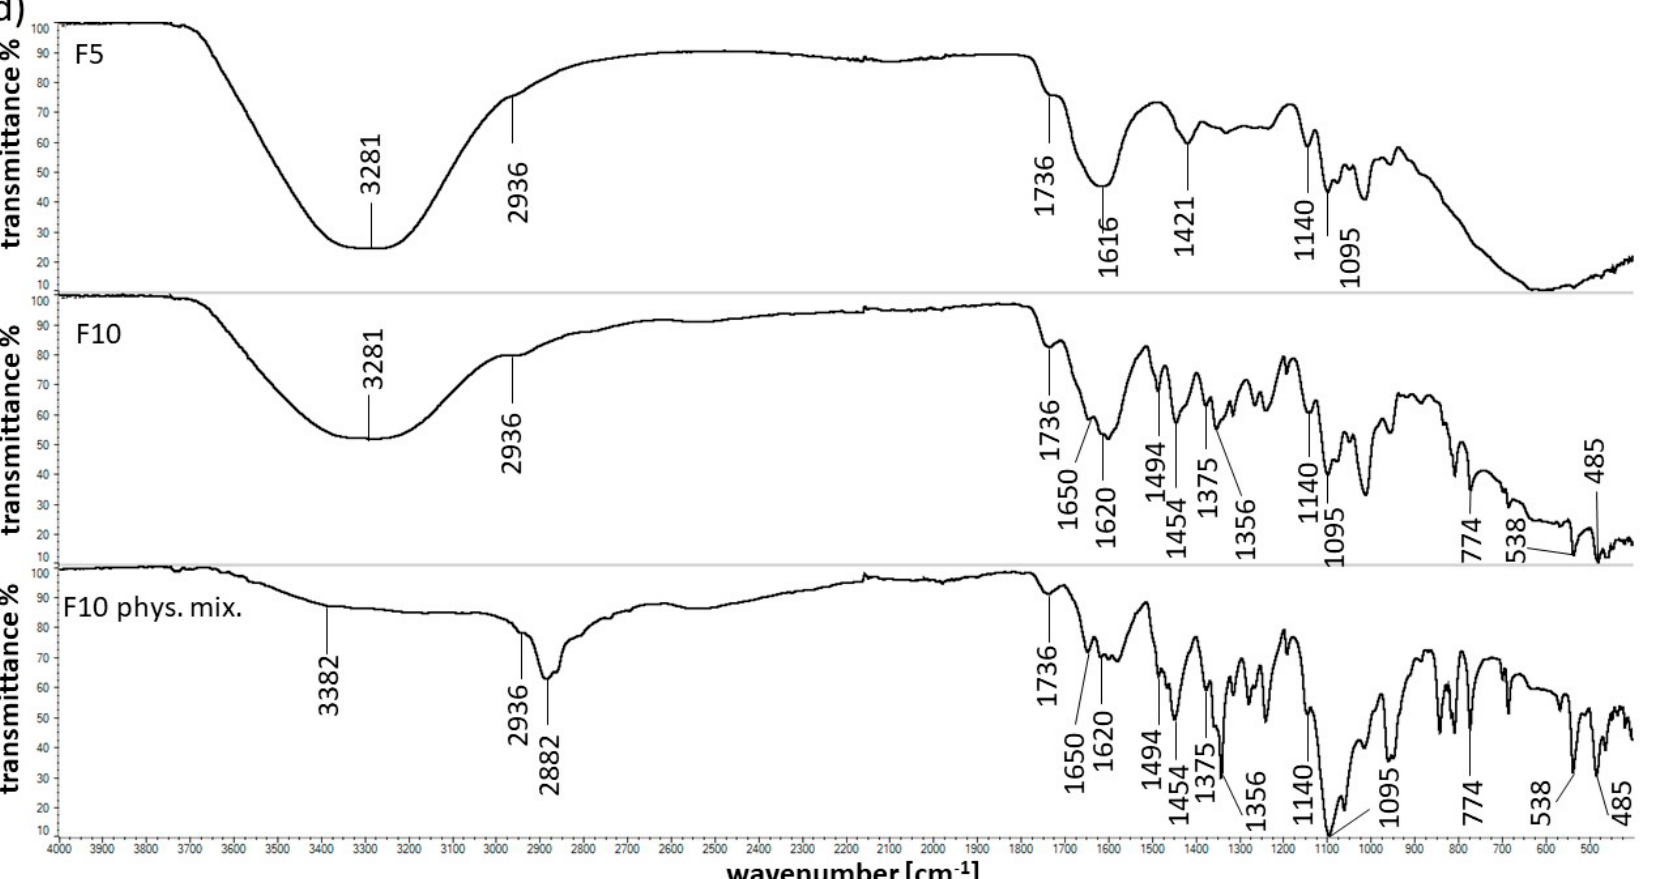
Figure 6. The FTIR spectra of the formulation of ( a ) F2, F7 and its physical mixture; ( b ) F3, F8 and its physical mixture ( c ) F4, F9 and its physical mixture; ( d ) F5, F10 and its physical mixture.